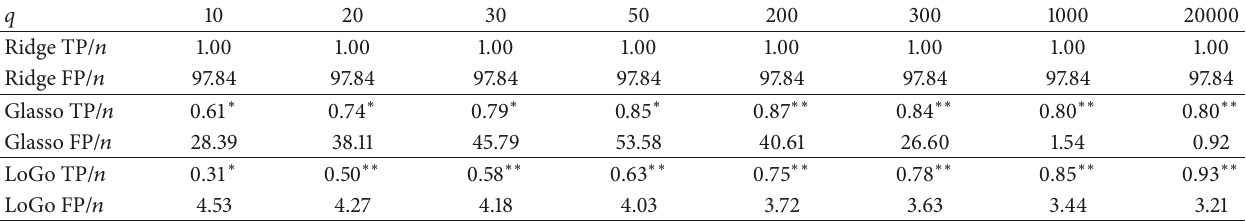
Table 2: Inference network validation: comparison between fraction of true positive (TP/ 𝑛 ) and fraction of false positive (FP/ 𝑛 ) . Data for ridge are only for comparison because it is a complete graph with all links present. The table reports only the case for the parameter 𝛾 = 0.1